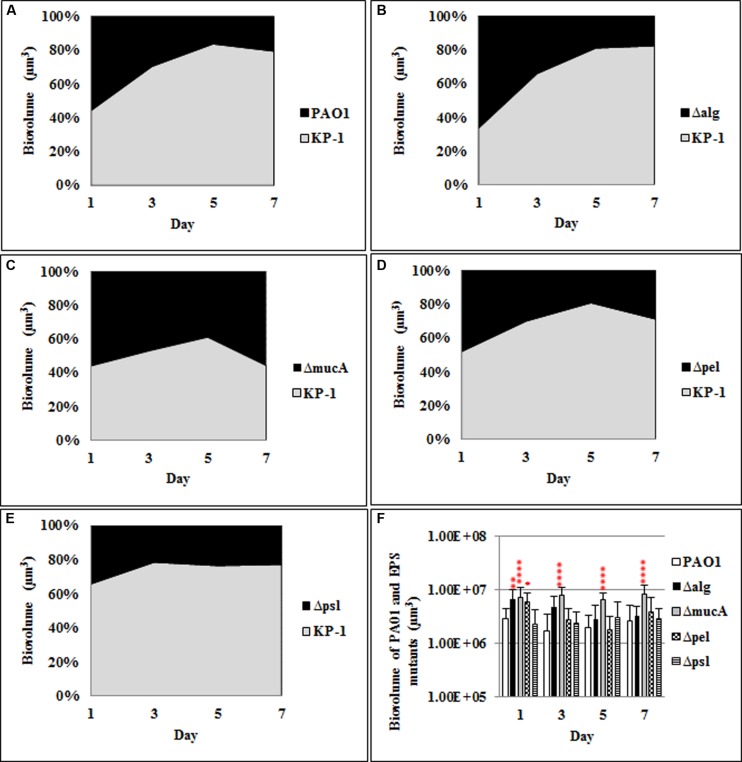
Spatial and temporal development of P. aeruginosa polysaccharide mutants grown with K. pneumoniae as dual species biofilms. The proportion of the two species was calculated by quantitative image analysis. (A)
P. aeruginosa WT, (B) Δalg, (C) ΔmucA, (D) Δpel, (E) Δpsl, and (F) biovolumes of P. aeruginosa and polysaccharide mutants. Statistical analysis was performed vs. the corresponding WT samples grown in parallel, which were very similar in all cases *P < 0.01, **P < 0.001, ****P < 0.0001.